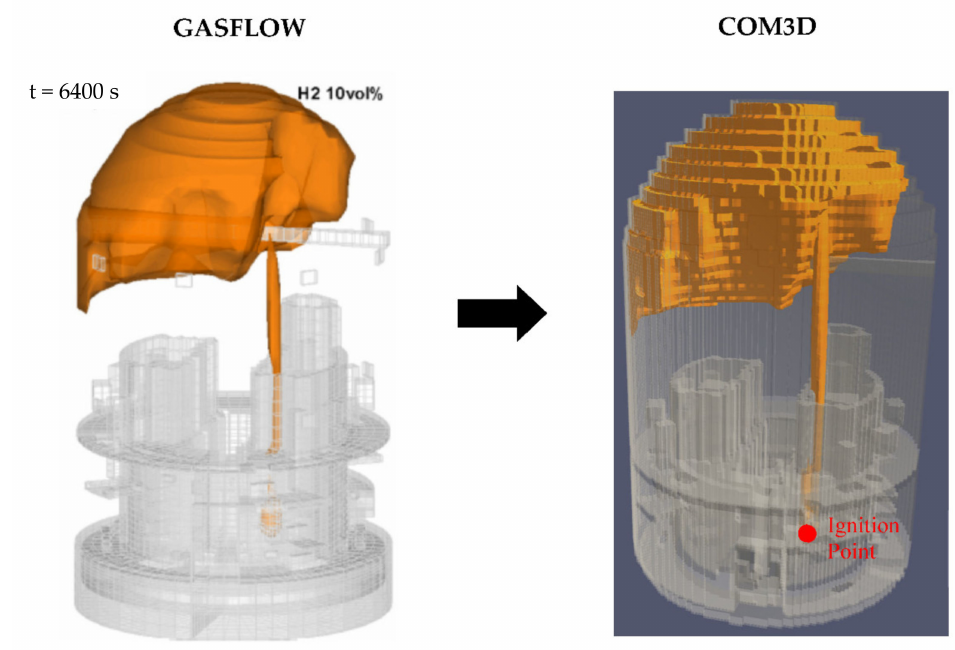
Figure 7. Iso-surface of H 2 10% in the grid model of GASFLOW and